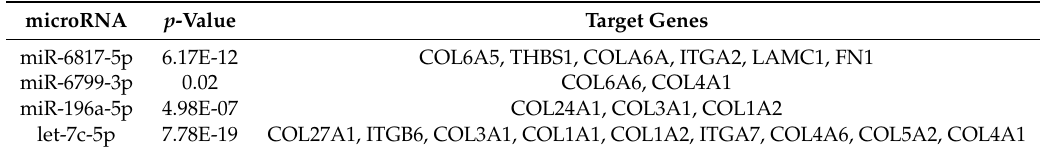
Table 4. miRNAs related to ECM-receptor interaction among 17 miRNAs selected by random forest and their target